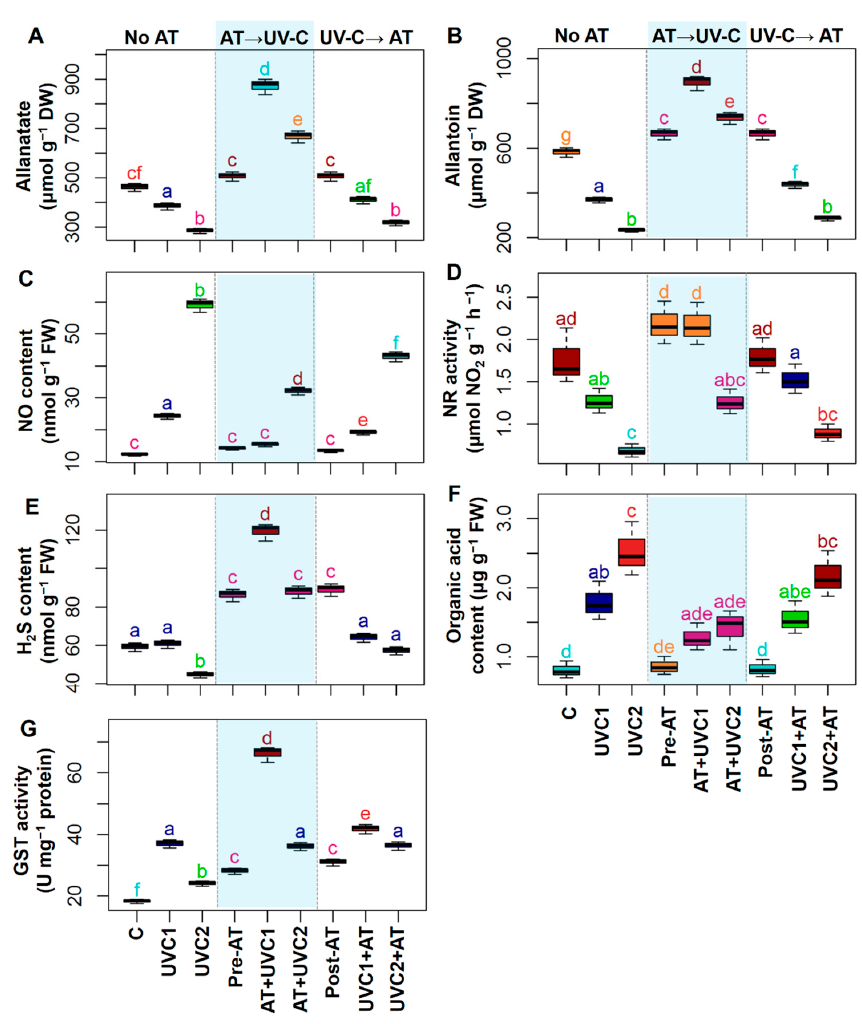
Figure 5. Effects of pretreatment and post-treatment of allantoin (AT) on allantoate contents ( A ), endogenous AT content ( B ), nitric oxide (NO) content ( C ), nitrate reductase (NR) activity ( D ), hydrogen sulfide (H 2 S) content ( E ), organic acid content ( F ), and glutathione S -transferase (GST) activity ( G ) in tomato plants grown 15 days in presence and absence of UVC stress. Each boxplot shows values of five independent replicates ( n = 5). Boxplots specified with the same letter(s) are statistically non-significant at p < 0.05 based on Tukey’s test. Treatments are the same as Figure